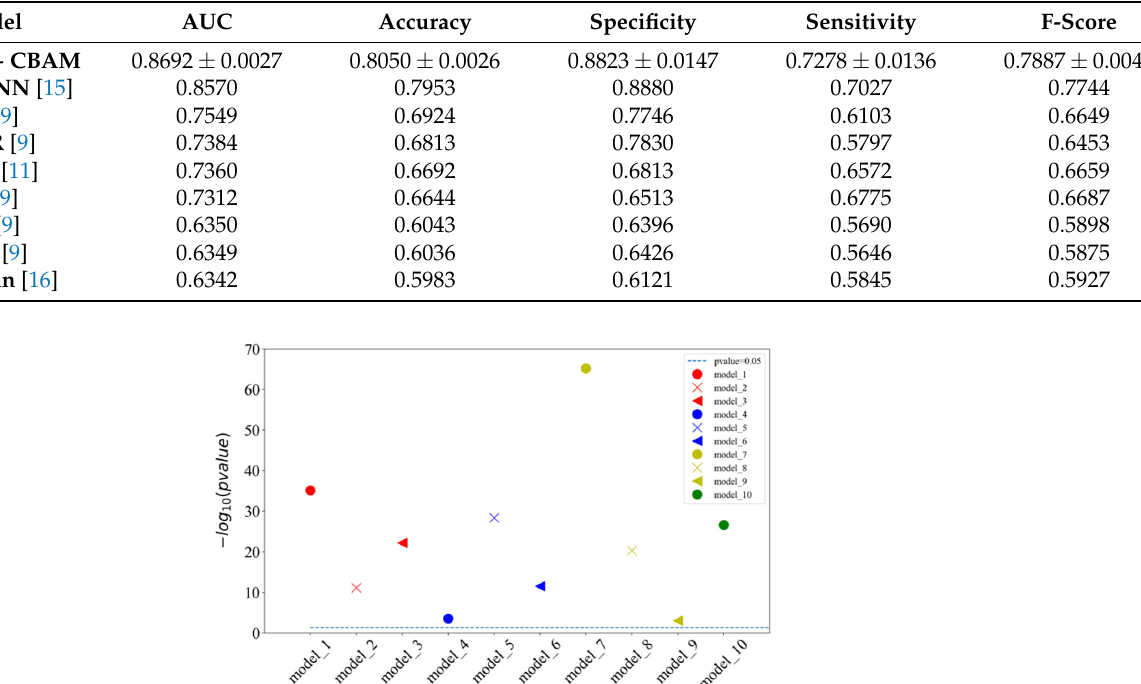
Table 2. Performance comparison by different classifier algorithms for peptide detectability prediction on the test set from GPMDB.